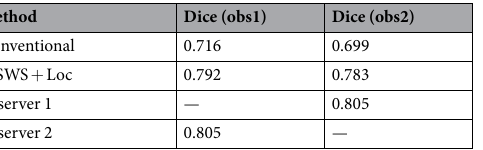
Table 3. A performance comparison between conventional method, MSWS + Loc architecture, and human